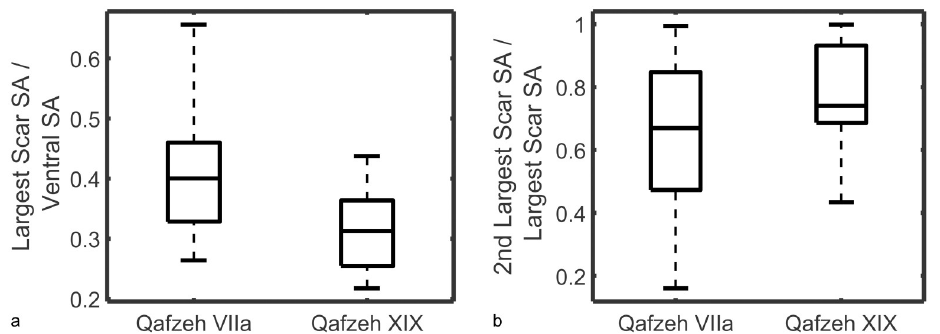
Fig 8. Boxplots for layers VIIa and XIX of Qafzeh Cave, showing the ratio in surface area between the largest dorsal scar and ventral surface (a), and the ratio in surface area between the second largest and largest scar (b).